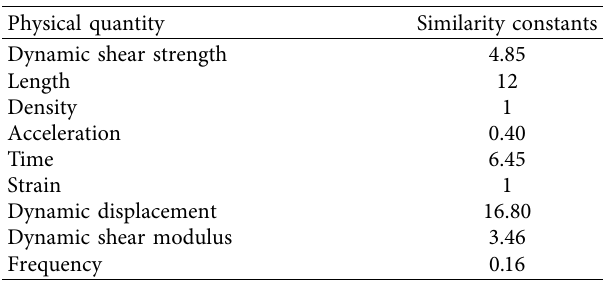
Table 10: Similarity coefficients.